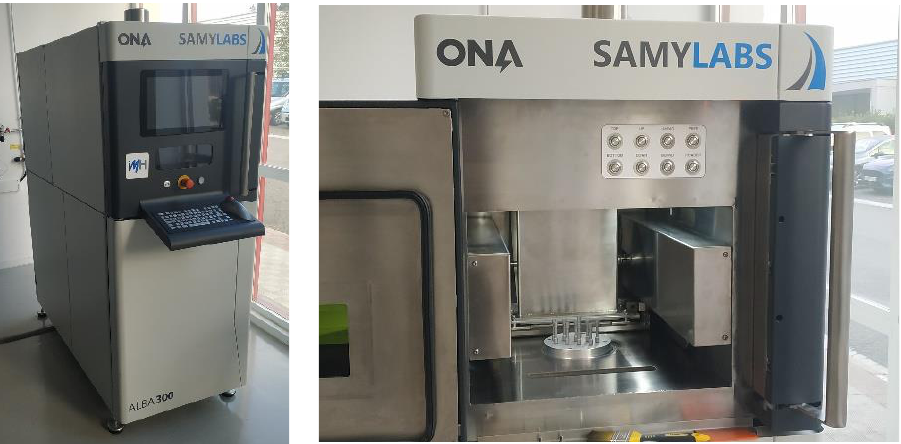
Figure 1. Samylabs ALBA300 machine at IMH Campus.